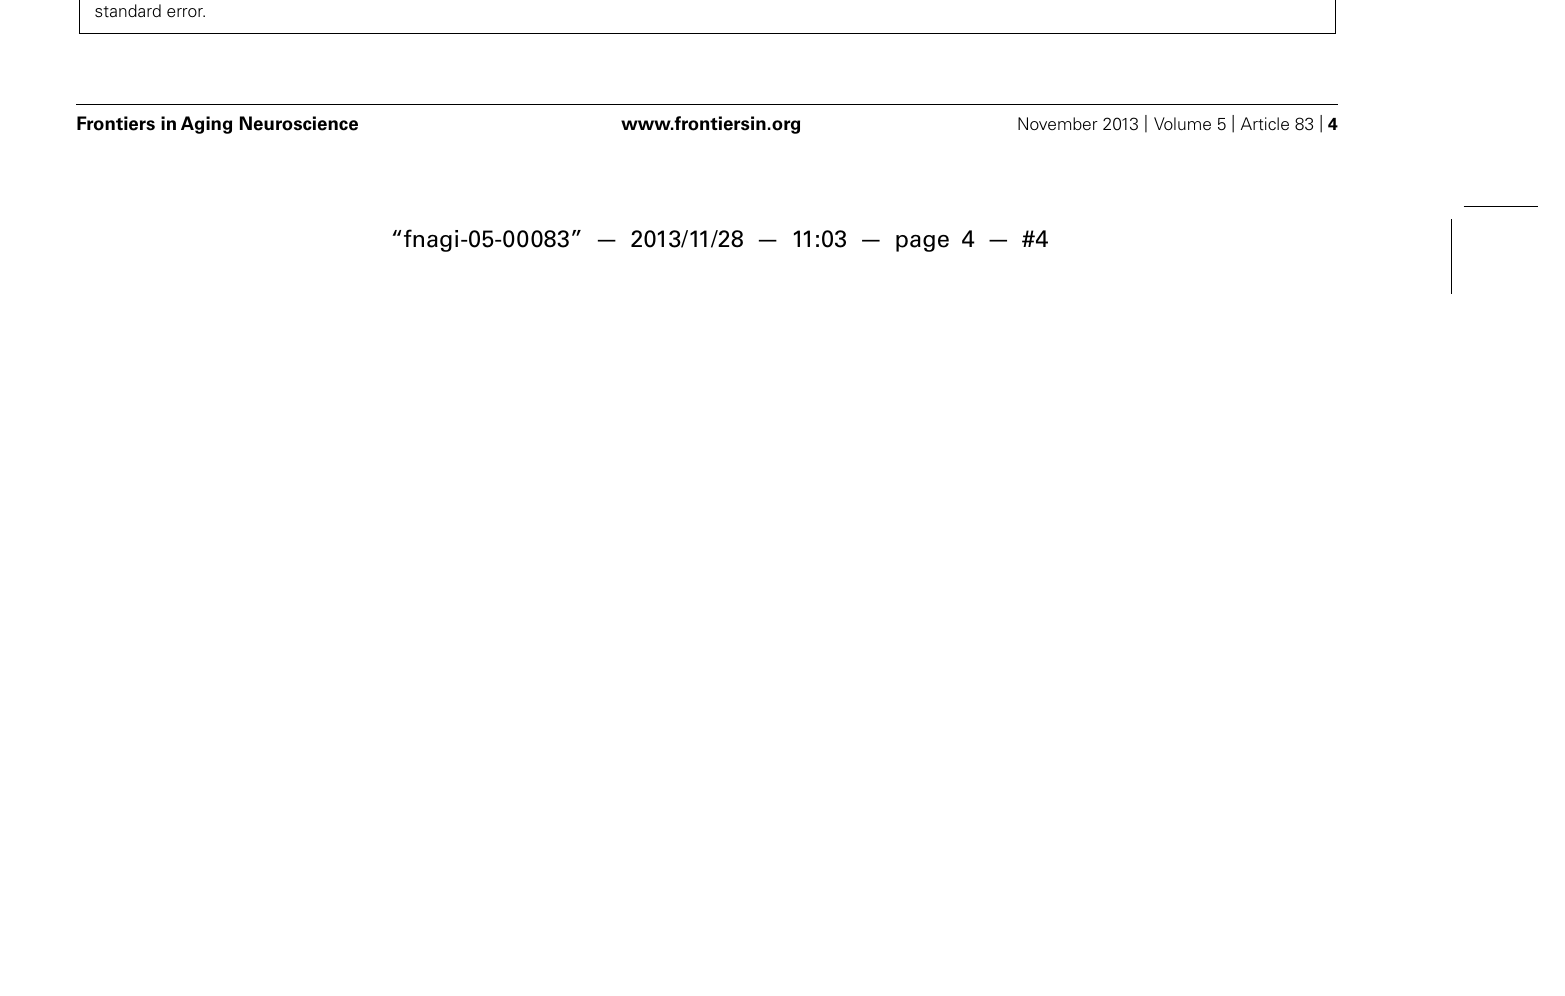
FIGURE 2 | Reaction time across blocks (gray = random; white = sequential) and sessions for young (circles) and older (squares) adults. Note that data is collapsed for Sleep/Wake and Muscle-based/Goal-based groups within in age group for the sake of simplicity. Error bars, which are small, represent standard